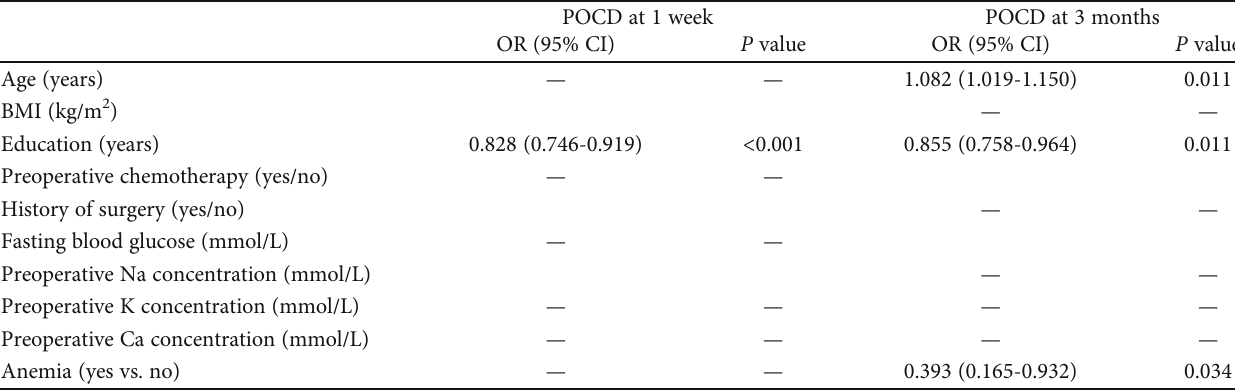
Table 4: Multivariate analysis results for POCD at 1 week and 3 months after